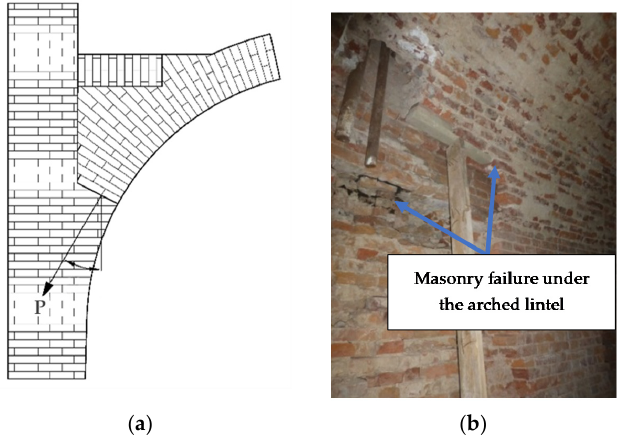
Figure 2. Arched lintels support zones in masonry ( a ) diagram; ( b ) example of failure